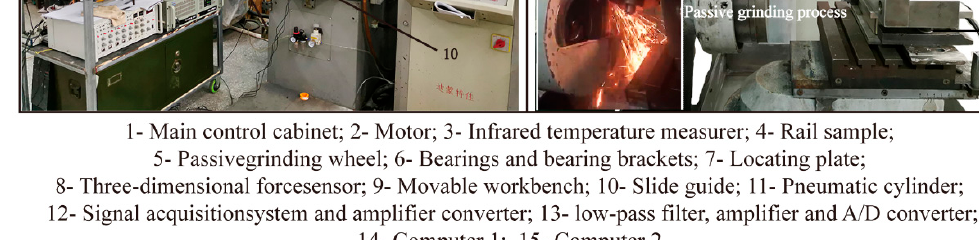
Figure 3. Structure of the passive grinding test machine, ( a ) overall structure, ( b ) structure of grinding.